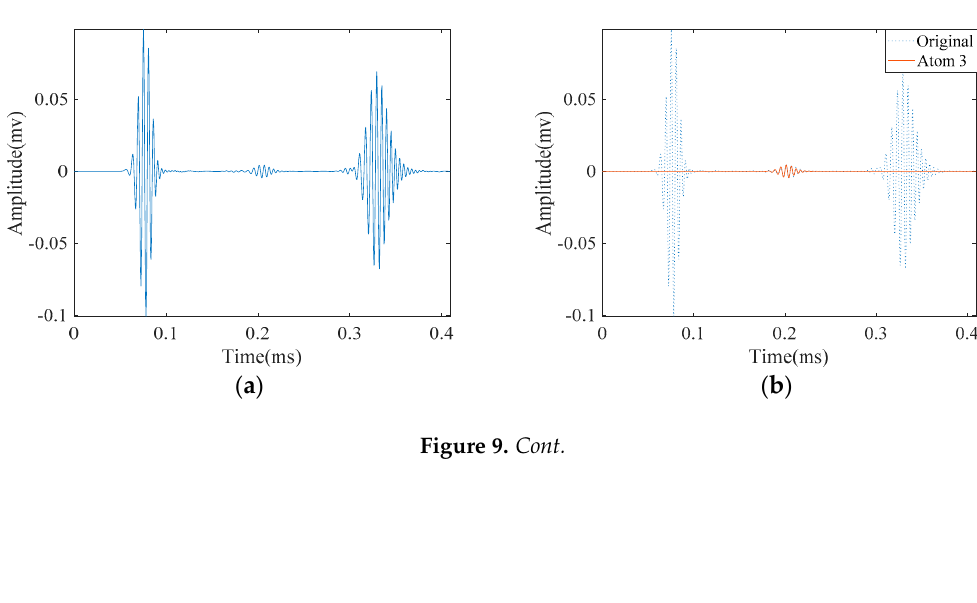
Figure 8. Results obtained by applying SDMP to the simulation signal in a pipe with a small crack: ( a ) the original signal of the propagating guided wave; ( b ) approximated atom 1—the direct signal; ( c ) approximated atom 2—the reflection from the pipe end; and ( d ) approximated atom 3—the reflection from the crack.